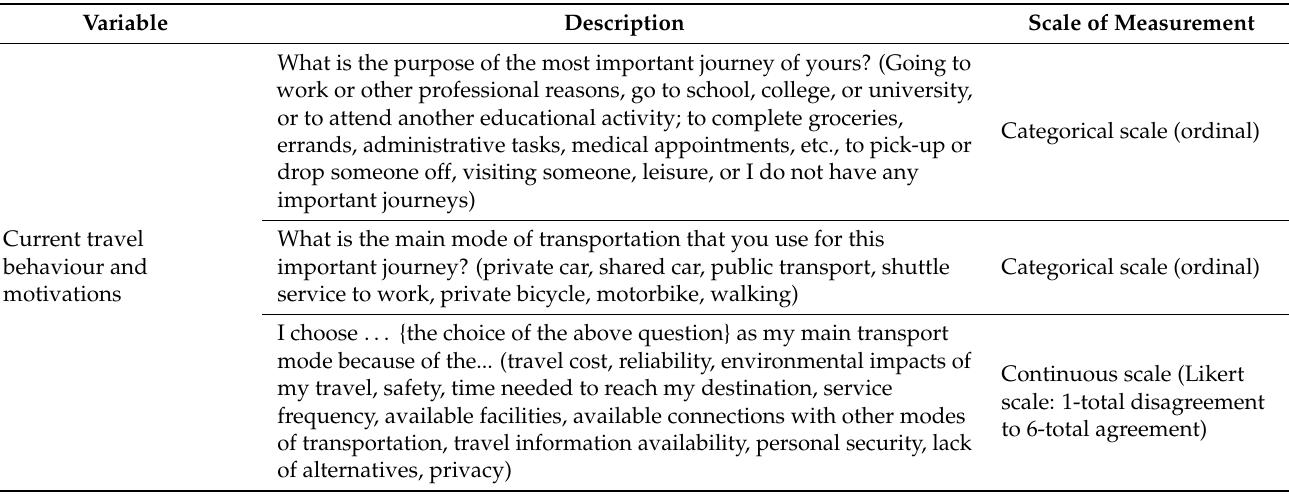
Table 1. The framework of the variables and scales of measurement used for